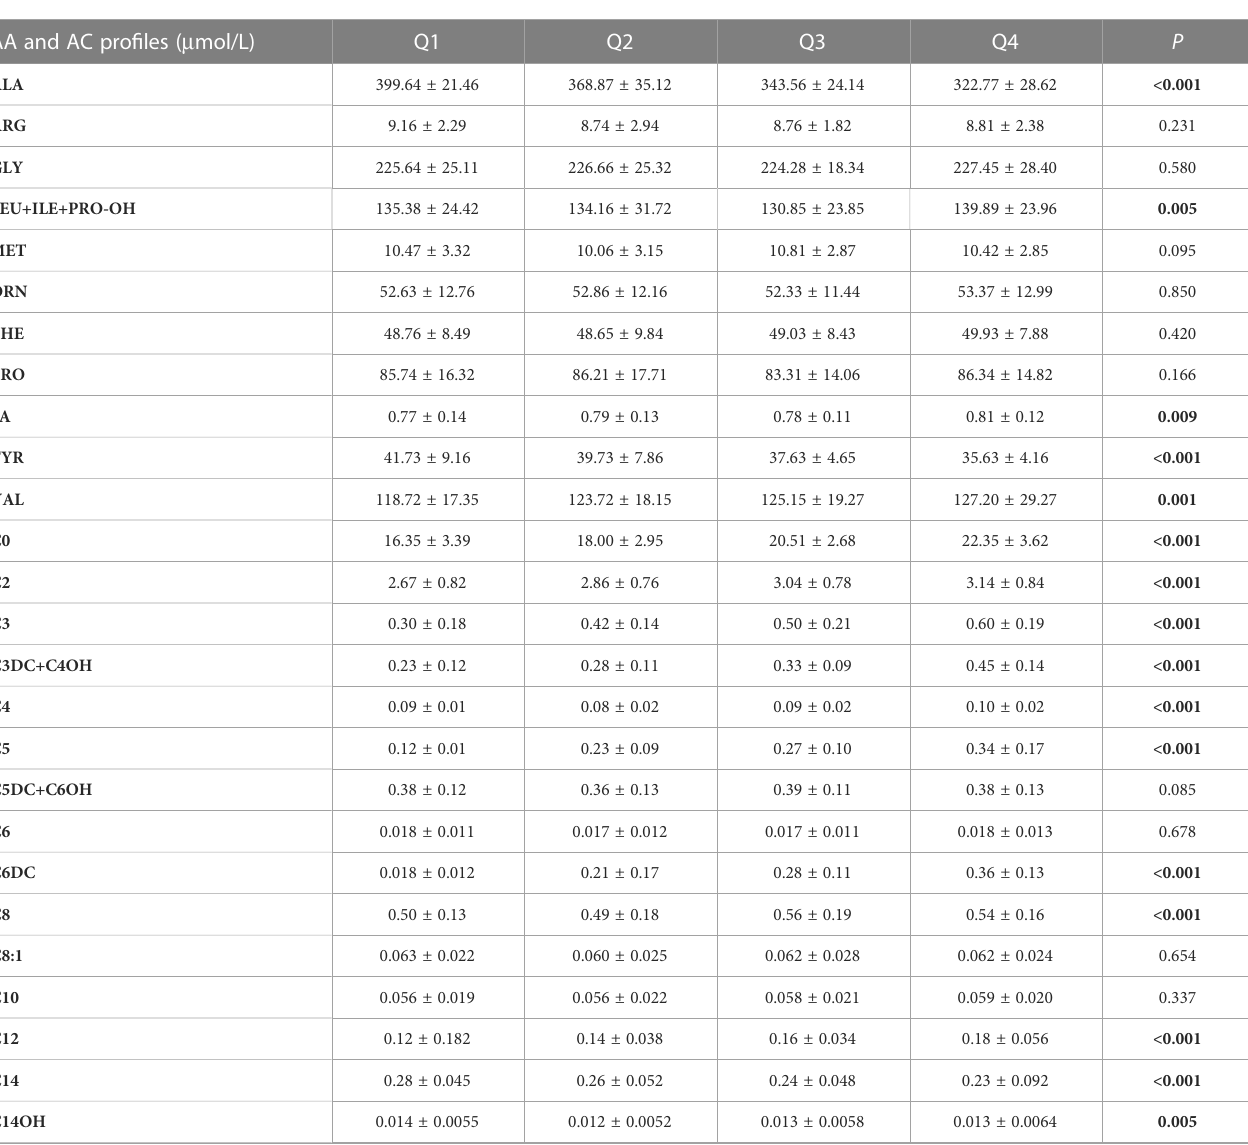
TABLE 3 Carnitine-related metabolites grouped by FT4 quartile (n = 844).